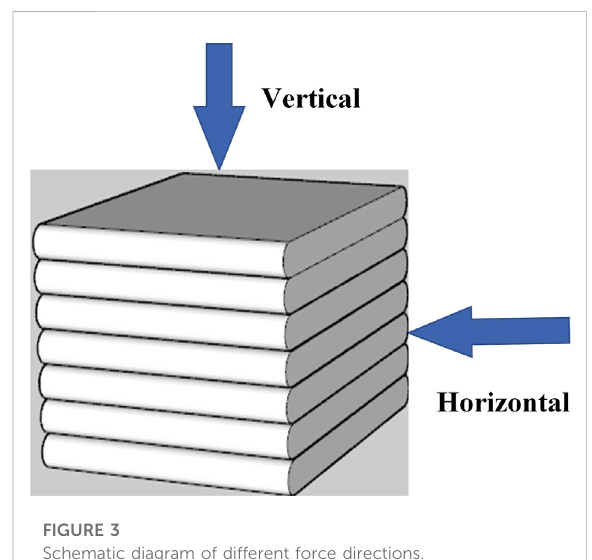
FIGURE 3 Schematic diagram of different force